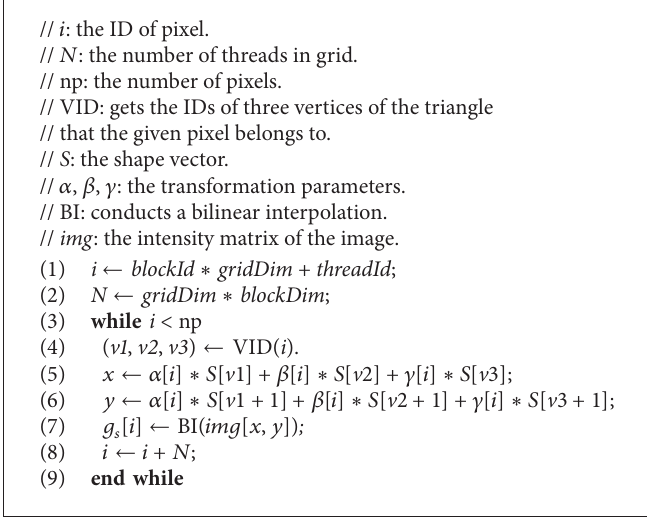
Algorithm 4: GPU-based method for calculating 𝑔 𝑠